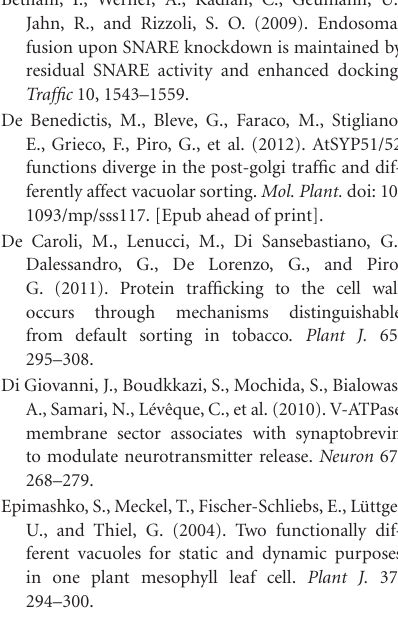
several membranes and change their action mechanism, as it was shown in the case of SYP5s: they can be active as t-SNARE on the TGN and/or PVC (3), or as i-SNARE when accumulated on the tonoplast (4). The compartments indicated in the figure are generic; their identity may change in different experimental systems and in differentiated cells. The figure summarize five membranes belonging to: the Golgi apparatus cisternae (GA), the early endosomes often identified with trans Golgi networks or recycling endosomes (TGN/RE), the late endosome in the form of multivesicular bodies or pre-vacuolar compartment (LE/MVB or PVC), and finally the tonoplast of the